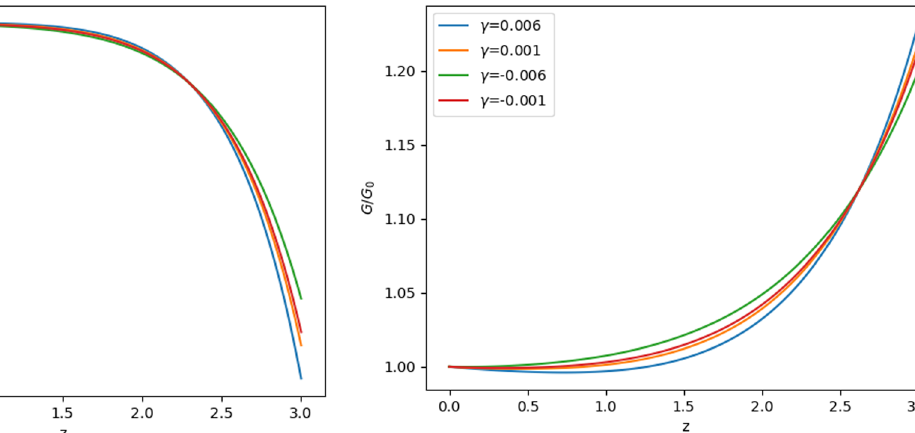
Figure 1: The variation of Λ in redshift, as normalised by the value of Λ 0 today.